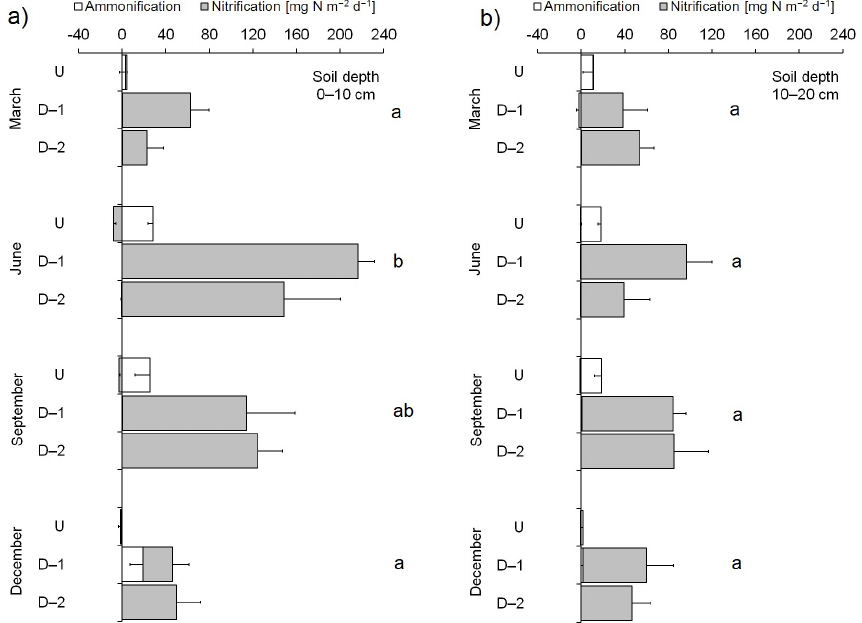
(a) and NH + (b) contents for the soil depth of 0–10cm (U = undrained; D-1 = drained 3 4